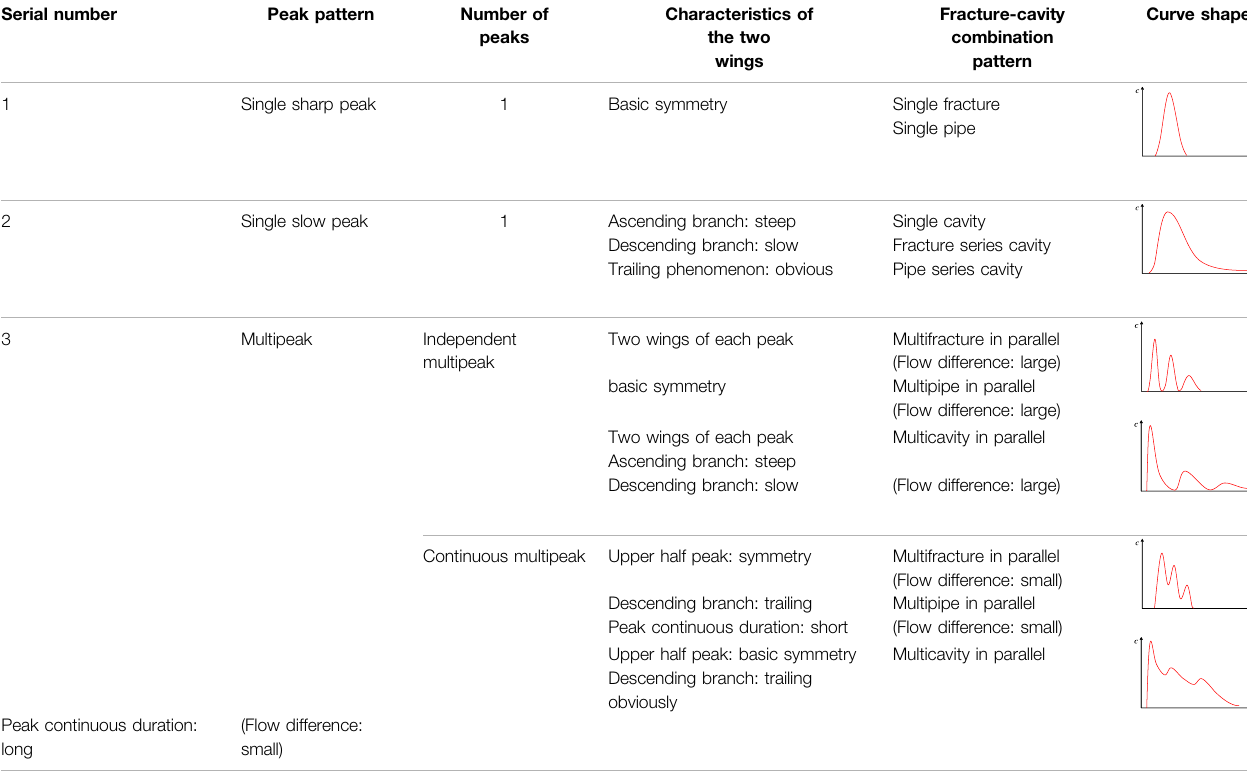
TABLE 1 | Classi fi cation characteristics of interwell tracer curve in fracture-cavity reservoir. Serial